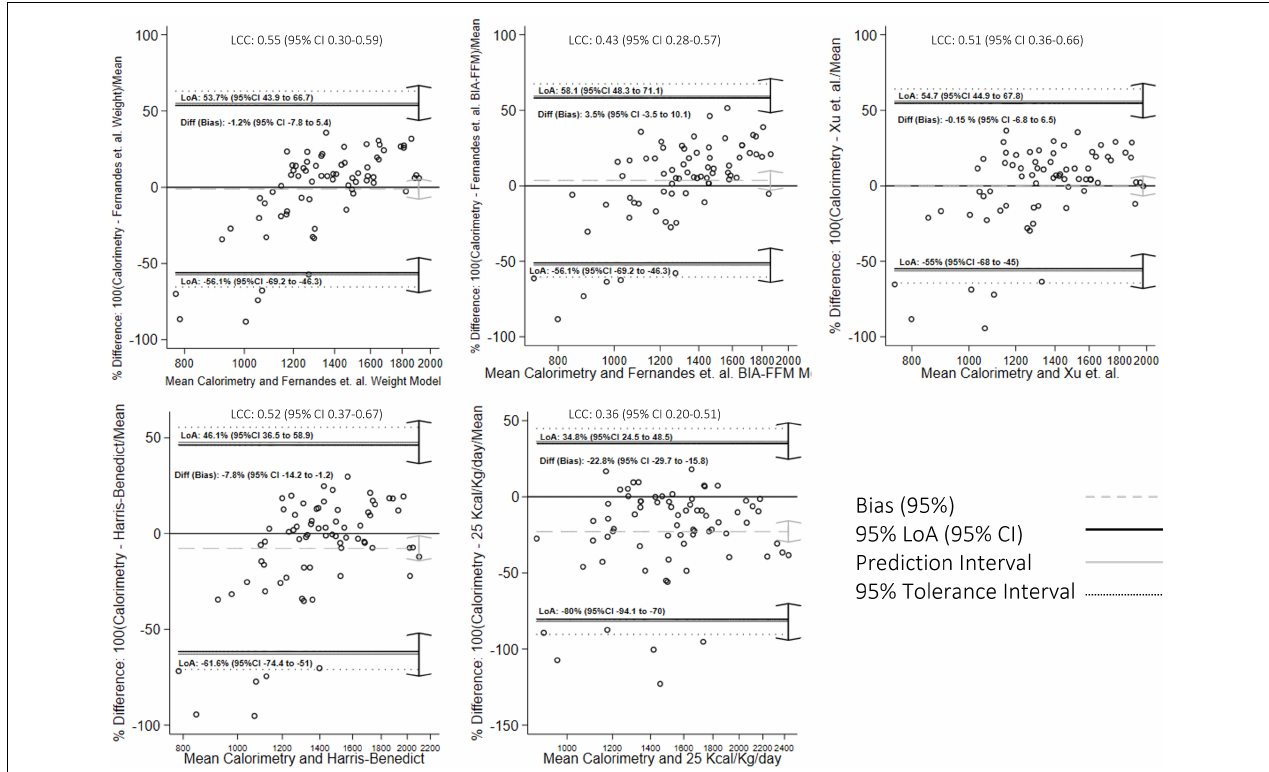
FIGURE 3 | Bland-Altman graph for concordance analysis between previously validated equations with indirect calorimetry measurements.